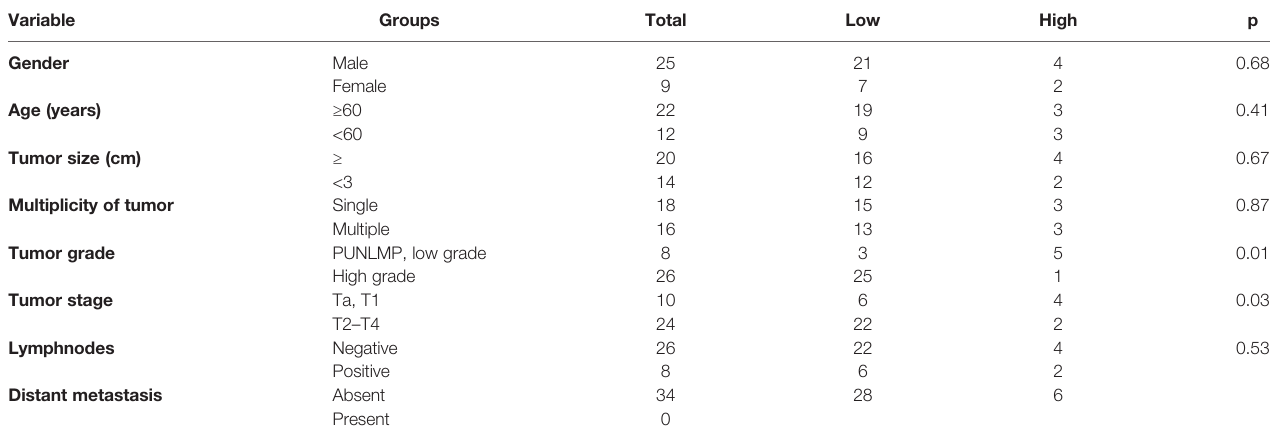
TABLE 1 | Correlation between TSPAN7 expression and clinical features of patients.